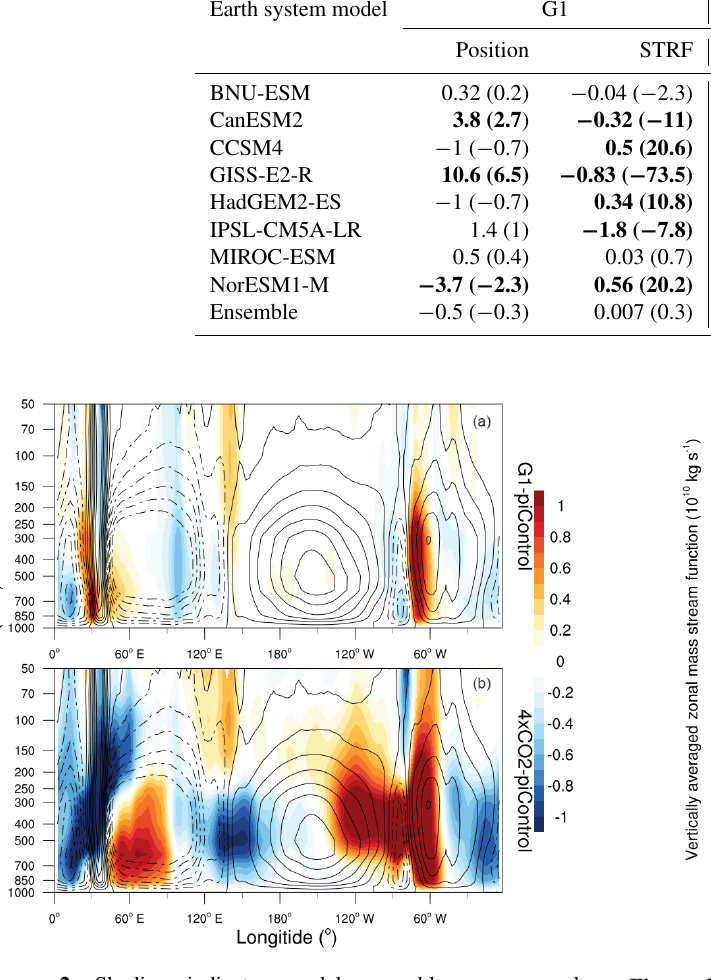
Figure 3. The vertically averaged zonal mass stream function (10 10 kgs − 1 ) (a) in piControl, G1, abrupt4xCO2 experiment for en- semble mean, ERA-Interim and NCEP2; their difference relative to piControl (b)